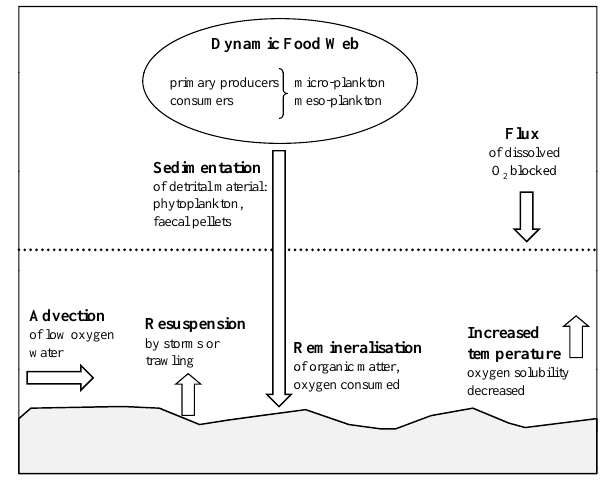
Fig. 8. Summary of processes which influence dissolved oxygen concentration at Oyster Grounds and North Dogger during the strat- ified